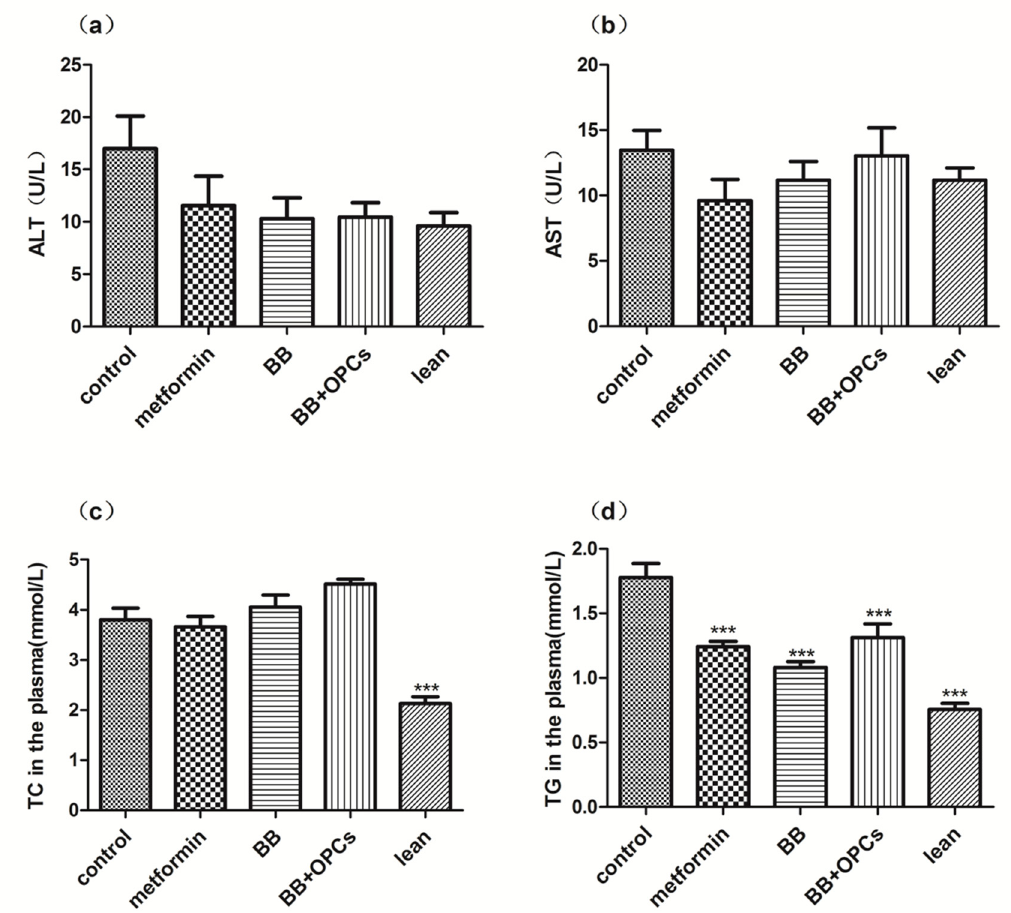
Figure 3. Effects of compounds on ALT, AST, TC, TG levels in db / db mice. The db / db mice were treated with the vehicle, 150 mg/kg of metformin, 200 mg/kg of BB and 200 mg/kg of BB plus 60 mg/kg of OPCs for 5 weeks. Then, the ( a ) ALT in the plasma. ( b ) AST in the plasma. ( c ) TC in the plasma. ( d ) TG in the plasma were measured. Data are presented as mean ± SEM of eight mice in each group. *** p < 0.001 vs. untreated control.